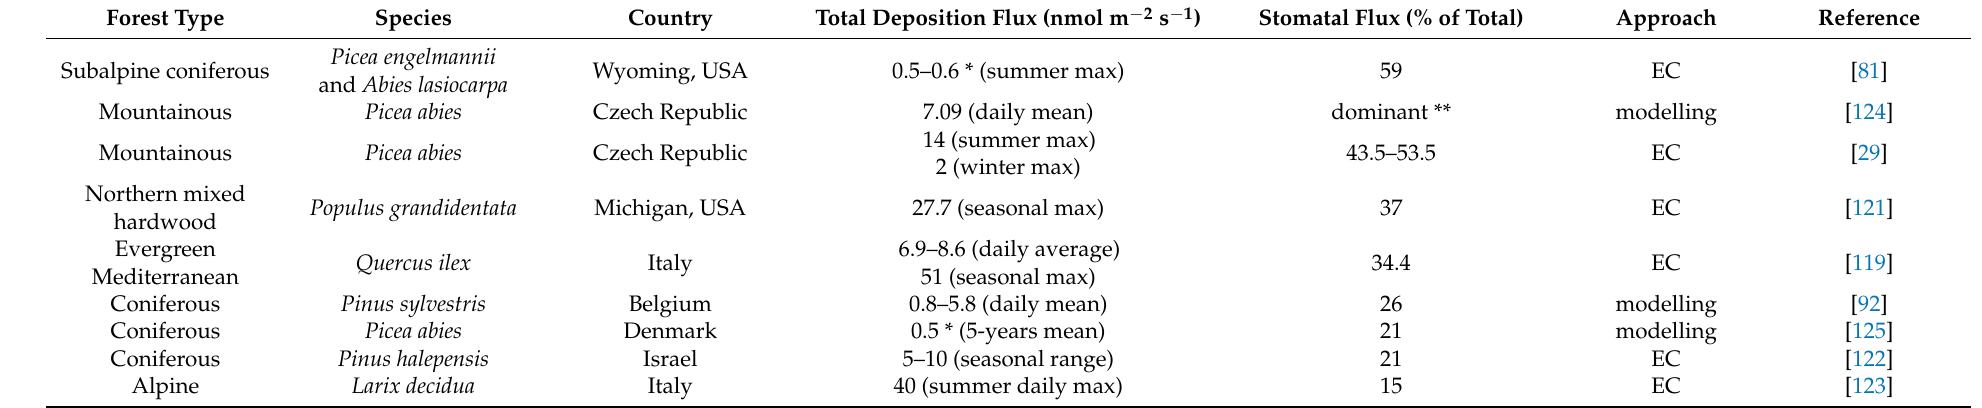
Table 1. Examples of fractions of stomatal O 3 fluxes to total O 3 fluxes from different forest ecosystems. Notes: EC—eddy-covariance; *—Total deposition flux in µ g m –2 s –1 ; **—value not